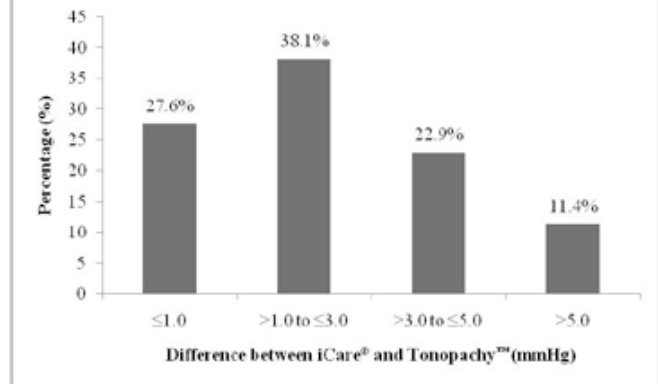
Figure 6: Frequency distribution of the difference between iCare ® and Tonopachy™